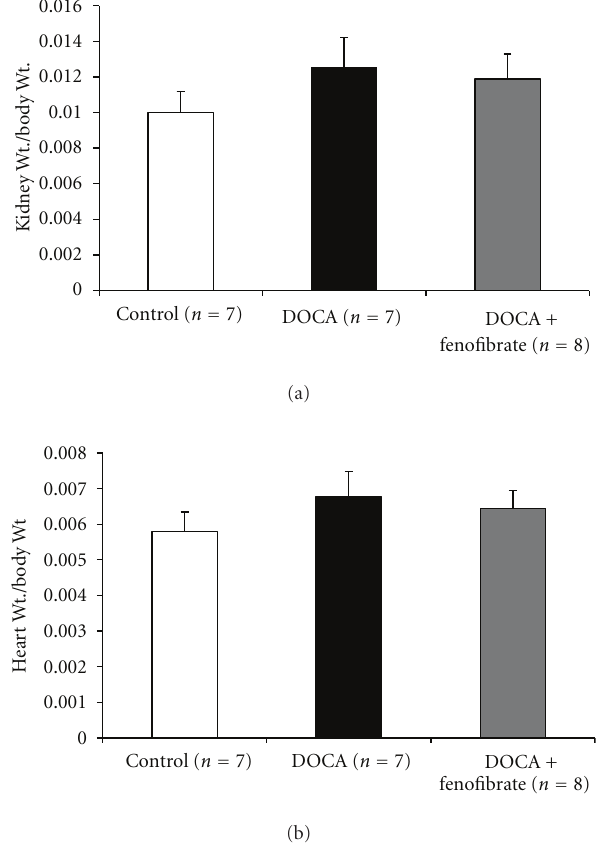
Figure 2: Kidney- and heart-weight-to-body-weight ratios in control, DOCA-salt-treated, and DOCA + fenofibrate-treated